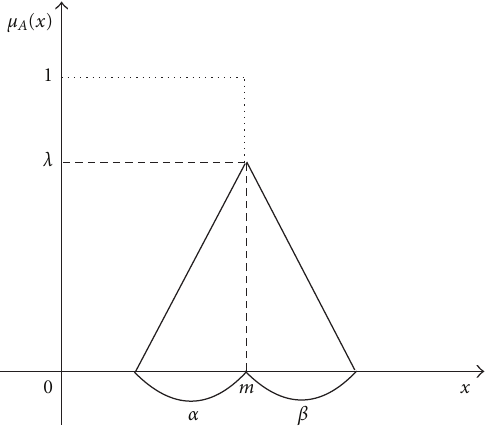
Figure 1: Level λ -triangular LR fuzzy number A .